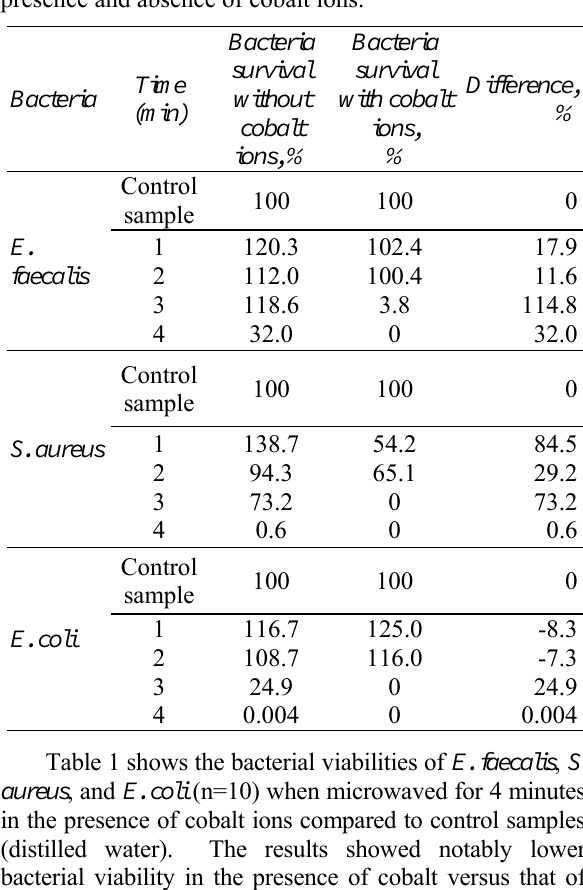
Table 1: Bacterial survival of E. faecalis, S. aureus, and E. coli at various times using microwave heating in the presence and absence of cobalt ions.